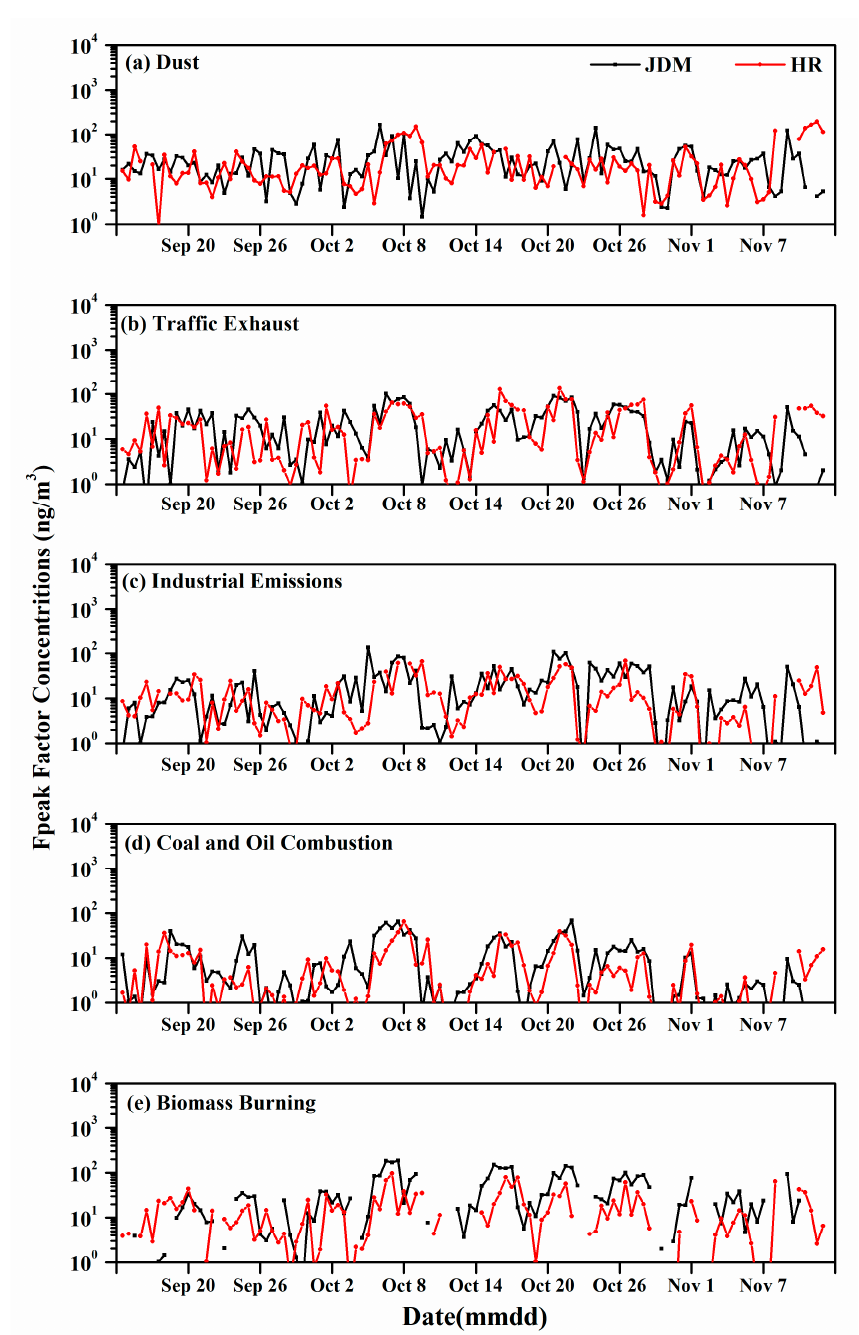
Figure 7. Time series of source contributions of the five factors (( a ) dust, ( b ) traffic exhaust, ( c ) industrial sources, ( d ) coal and oil combustion and ( e ) biomass burning) to metallic elements in PM 2.5 resolved by PMF in Beijing urban site (JDM) and suburban site (HR).